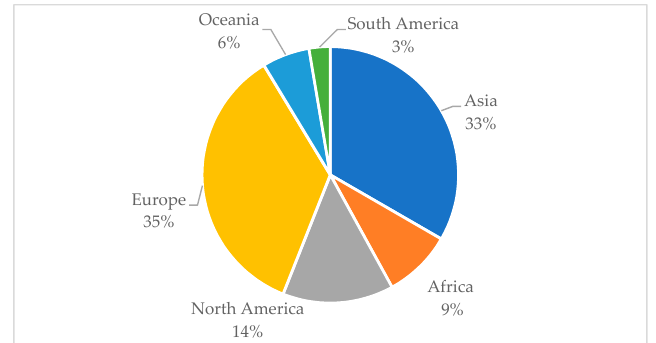
Figure 3. Distribution of retrieved research articles per continent.